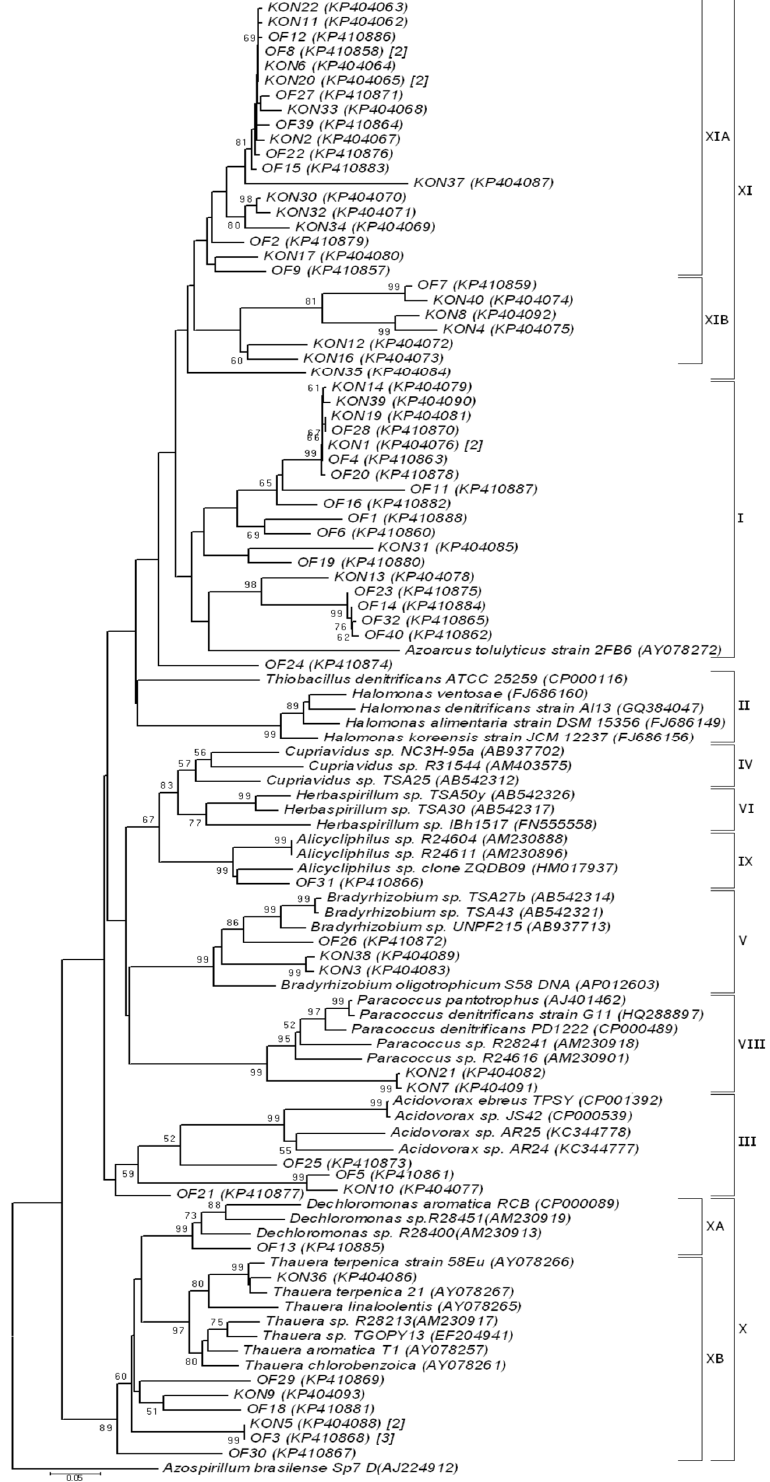
Figure 6. Phylogenetic analysis of nucleotide sequences of the nirS gene. The rooted phylogenetic tree was built on the basis of 102 sequences (63 test clones and 39 sequences obtained from the Gene Bank), using the algorithm of combining neighboring taxa. The figure shows self-sampling values above 50% for 500 repetitions. In parentheses () the accession numbers from the Gene Bank are shown, in square brackets [] the number of repetitions of the same sequence within the analyzed maple